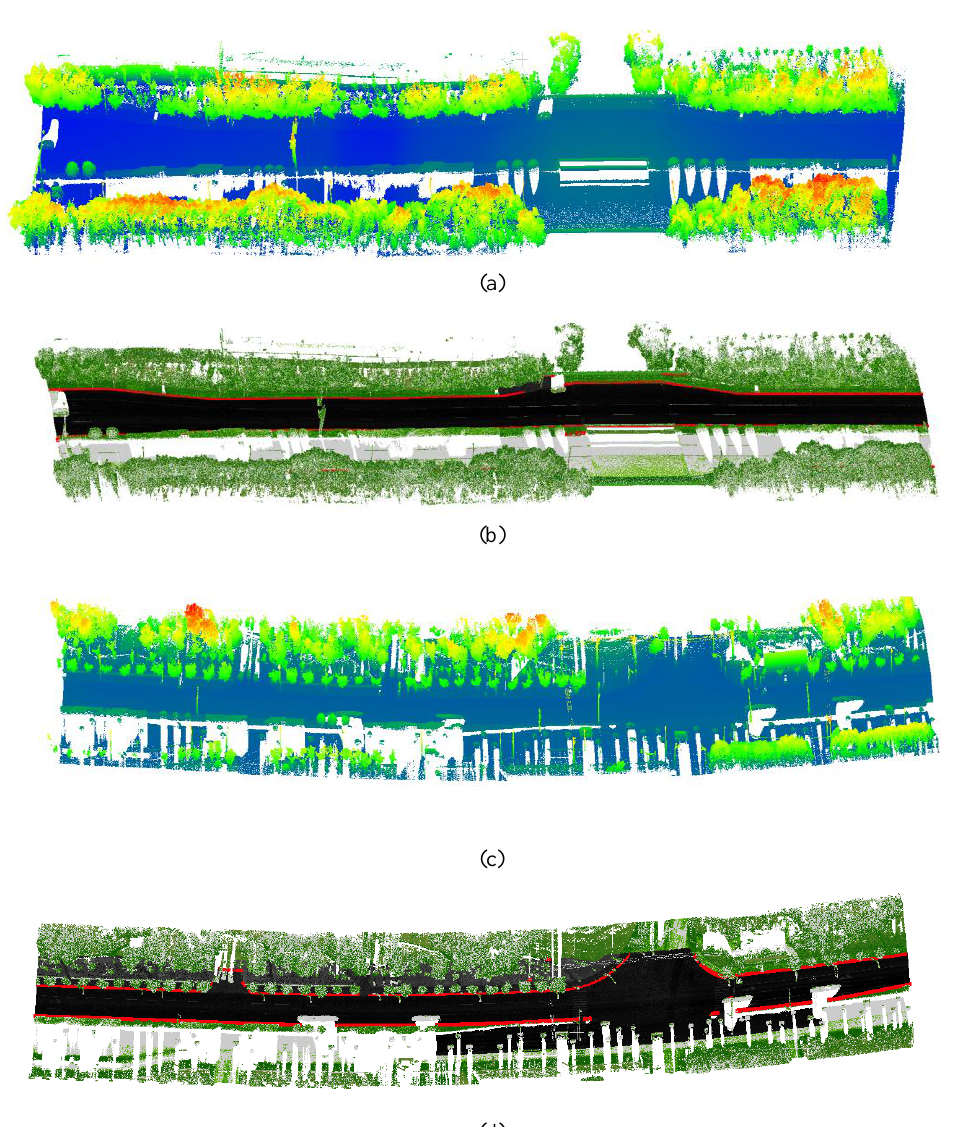
Figure 5. Extracted boundaries and driving free space: Data1: (a) raw data; (b) road boundary (red) and driving free space(black). Data2: (c) raw data; (d) road boundary (red) and driving free